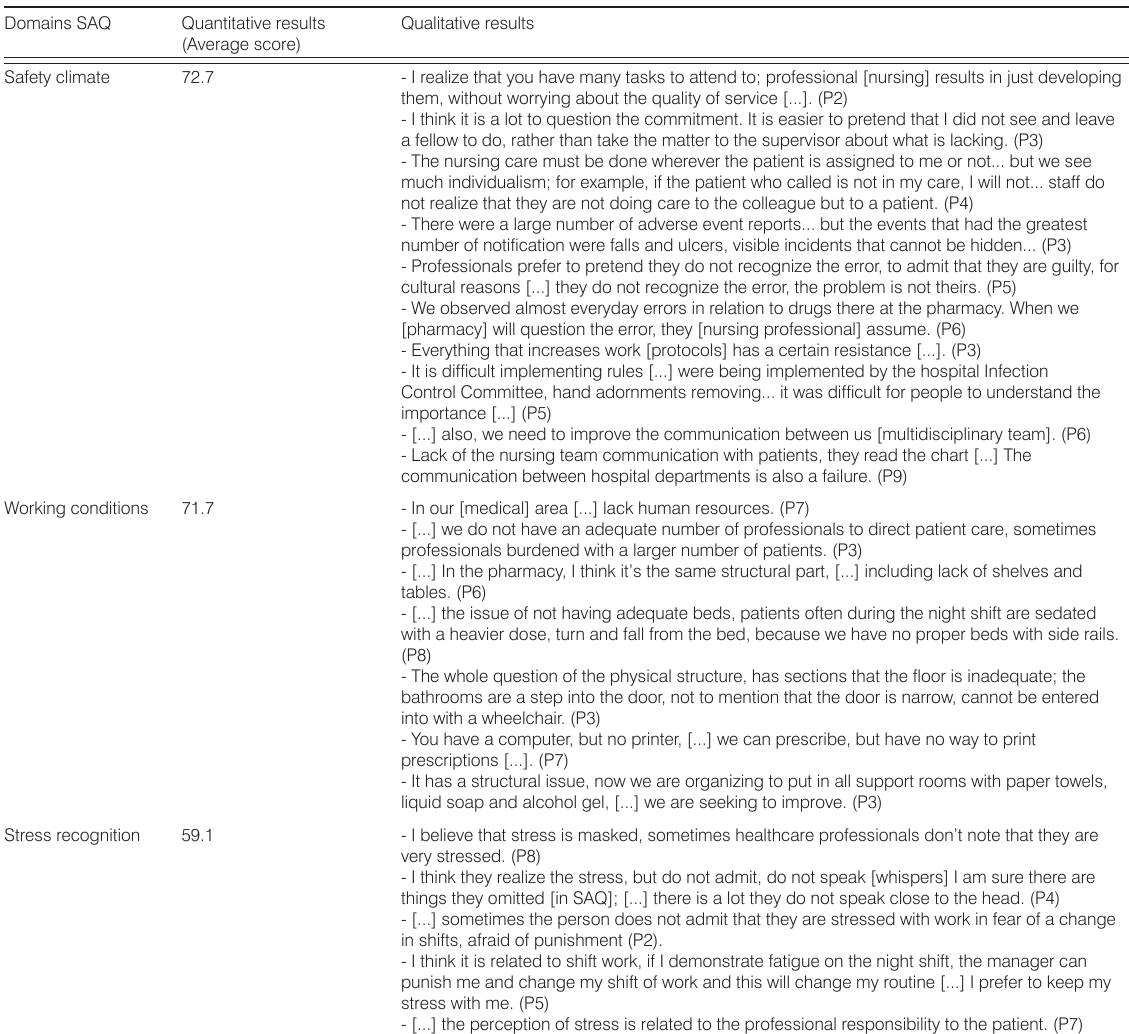
Table 3. Quotations of the focus group participants related to the areas of the SAQ that had negative